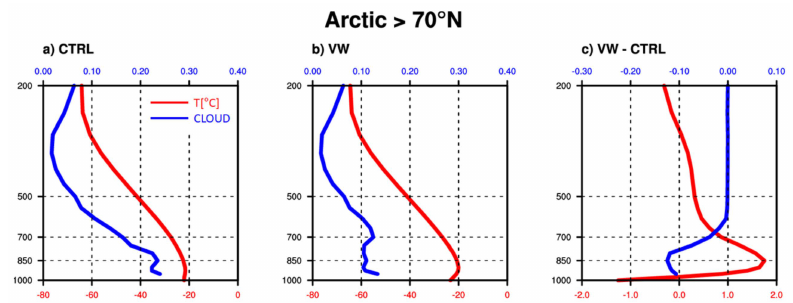
Figure 5. Vertical profiles of temperature (red) and COSP cloud fraction (blue) averaged over the Arctic during winter obtained from ( a ) CTRL, ( b ) VW, and ( c ) difference between VW and CTRL.